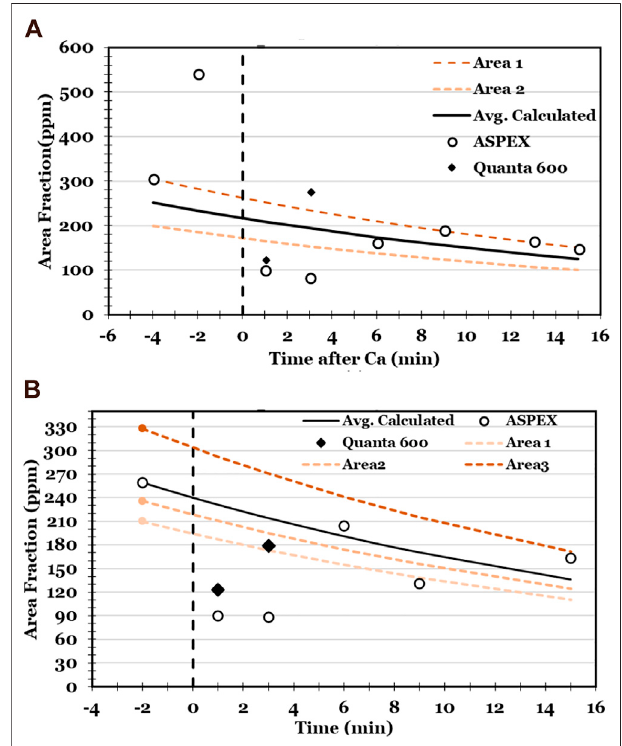
FIGURE 9 | Measured inclusion area fractions in experiments A and B. “ ASPEX ” and “ Quanta 600 ” indicate the SEM used in each analysis. The lines give expected inclusion fl otation trends.